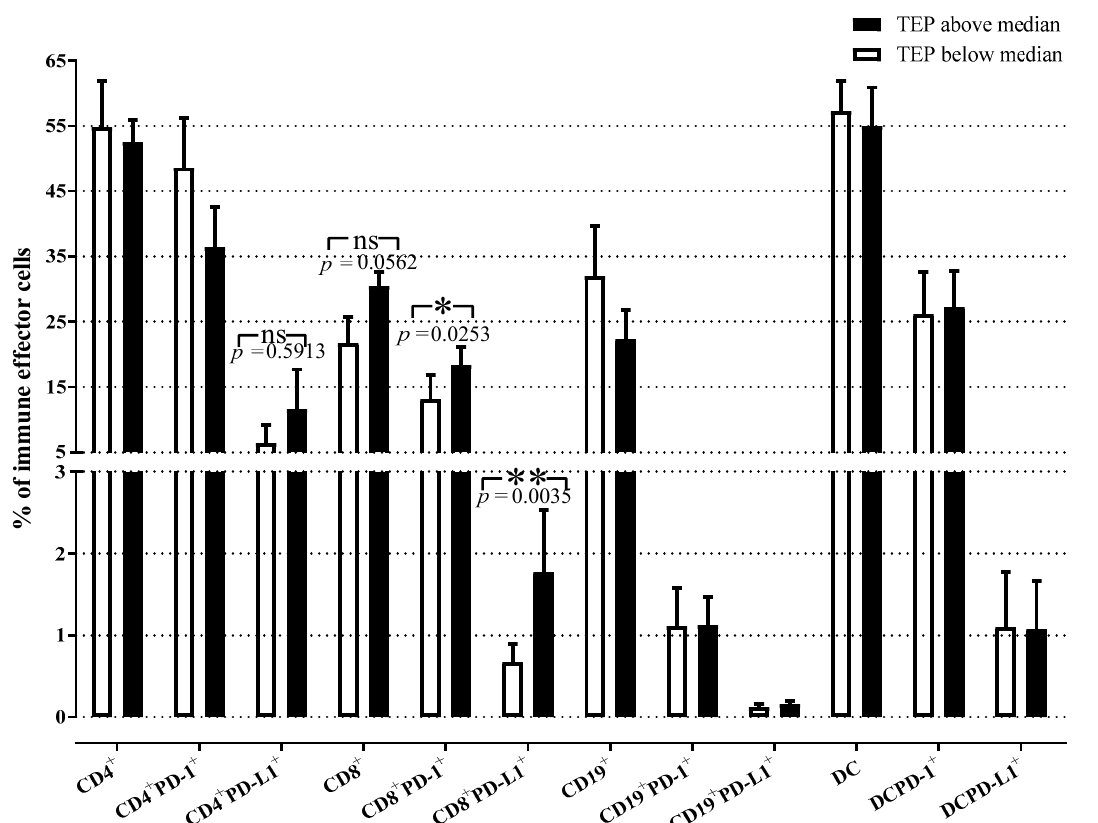
Figure 4. Relationship between TEP levels and peripheral immune cells in patients with NSCLC. Percentages of different effector immune cell subpopulations in stage IV patients are related to the TEP levels at baseline. The percentages of CD8 + PD-1 + and CD8 + PD-L1 + T cells were significantly increased in patients with high TEP levels as compared to patients with low TEP levels. The bars denote mean values ± SEM. Groups were compared by Mann–Whitney U test (TEP above vs. below median for CD4 + PD-L1 + , CD8 + PD-L1 + , CD19 + PD-L1 + , DCPD-L1 + ) and unpaired t -test (TEP above vs. below median for CD4 + , CD4 + PD-1 + , CD8 + , CD8 + PD-1 + , CD19 + , CD19 + PD-1 + , DC, DCPD-1 + ; open bars = TEP below the median, closed bars = TEP above the median; TEP = total sEV protein; *, p < 0.05; **, p < 0.01).